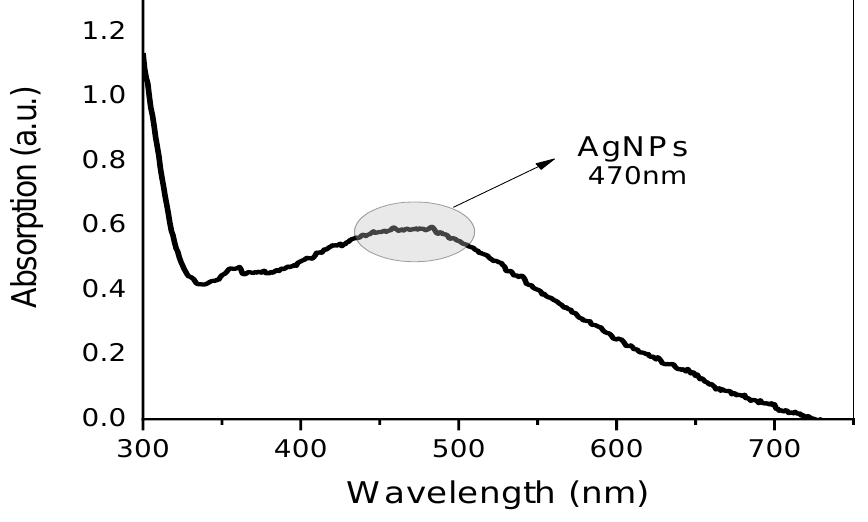
Figure 3. UV - visible spectrum of biosynthesized Ag NPs. Figure 3. UV-visible spectrum of biosynthesized Ag